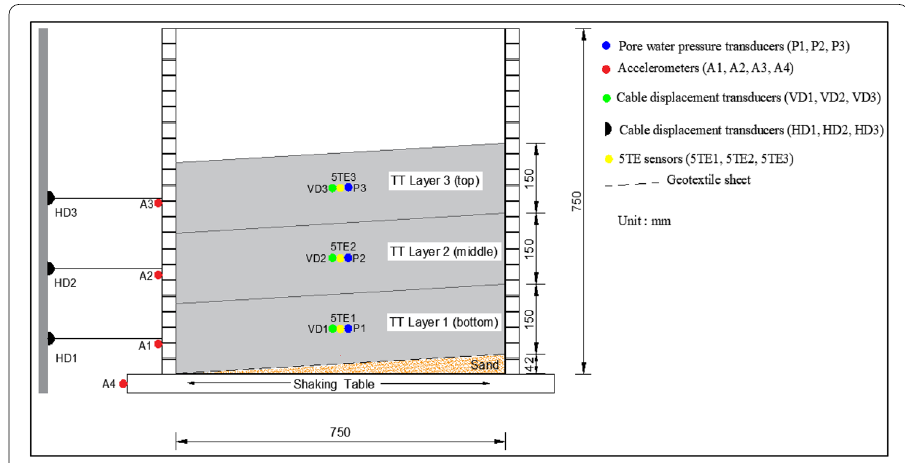
Fig. 4 The used Flexible Laminar Shear Box (FLSB) on the shaking table with the positions of